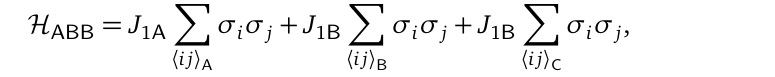
) . Dimers , W 1 2 by 1, while those crossing angled lines decrease W by 1. i i and W are both even, and 1 2